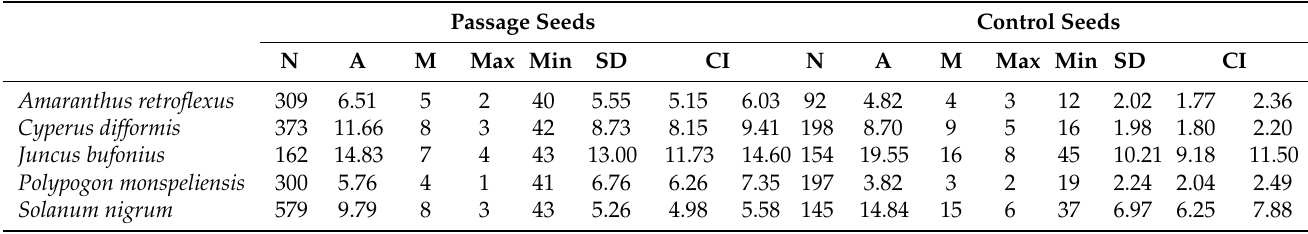
Table 5. Germination time (in days) of five plant species after passage through guts of seven LBBG, and for control seeds. A.: Average; M.: Median; S.D.: Standard deviation. C.I.: 95% Confidence Interval.